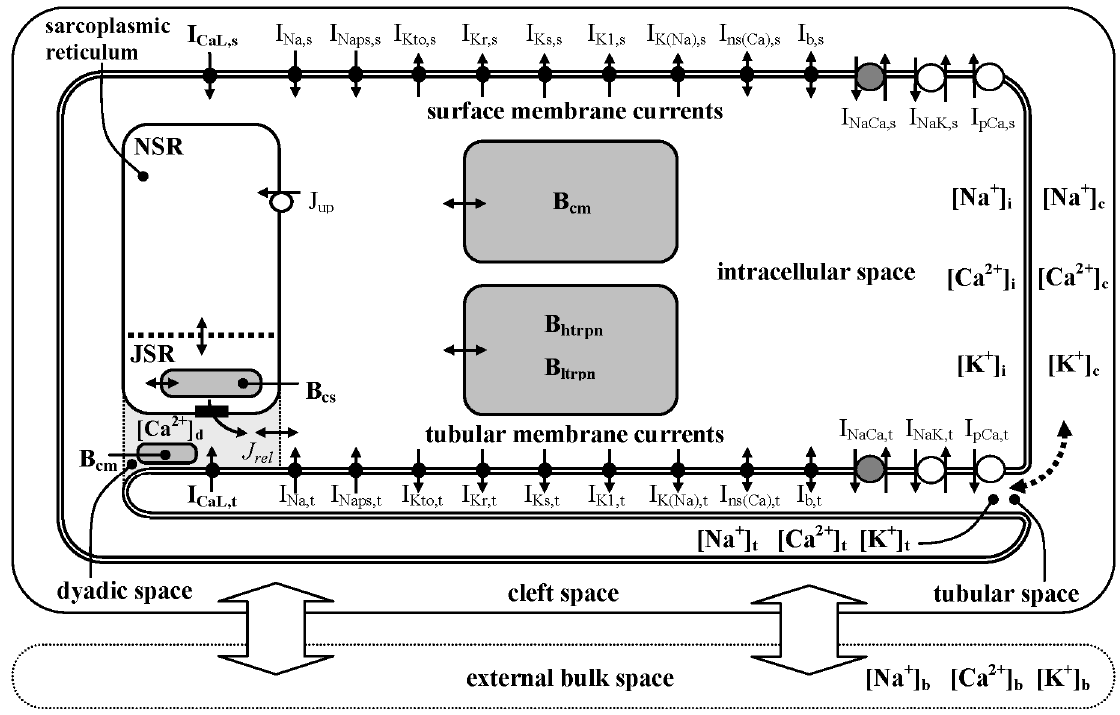
), L-type calcium current ( I ), transient outward potassium current sodium current ( I Naps CaL ( I ), rapid and slow components of delayed rectifier potassium current ( I and I ), Kto Kr Ks inward rectifying potassium current ( I ), background currents ( I ), sodium-activated K1 b potassium current ( I ), calcium-activated non-specific current ( I ), sodium-calcium K(Na) ns(Ca) ), sodium-potassium pump current ( I ) and calcium pump current exchange current ( I NaCa NaK ( I ). The intracellular space contains the cytosol (i), the dyadic space (d), network and pCa junctional compartments of sarcoplasmic reticulum (NSR, JSR) and endogenous Ca 2+ ), troponin (B , B ) and calsequestrin (B )]. The t-tubular buffers [calmodulin (B cm htrpn ltrpn cs space is partitioned into nine concentric cylindrical segments (details are given in the Supplementary Information). J represents Ca 2+ flow via SR Ca 2+ pump and the small up filled rectangles in JSR membrane ryanodine receptors. The small bi-directional arrows denote Ca 2+ diffusion. Ion diffusion between the t-tubular and cleft spaces is represented by the dashed arrow and between cleft and external bulk spaces by thick